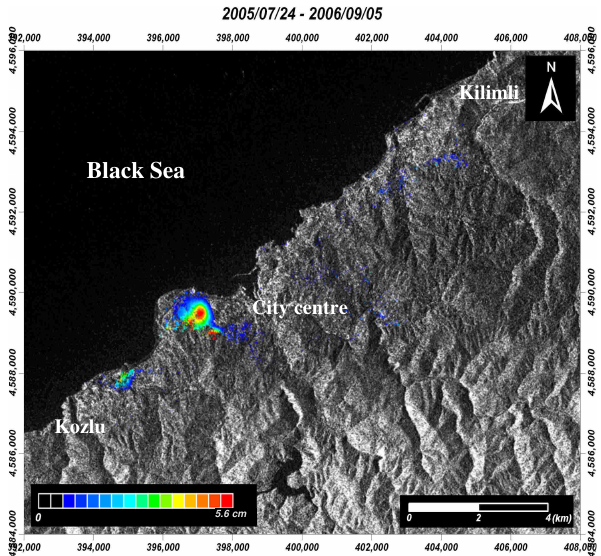
Figure 4. D-InSAR processing procedure used in this study [22].